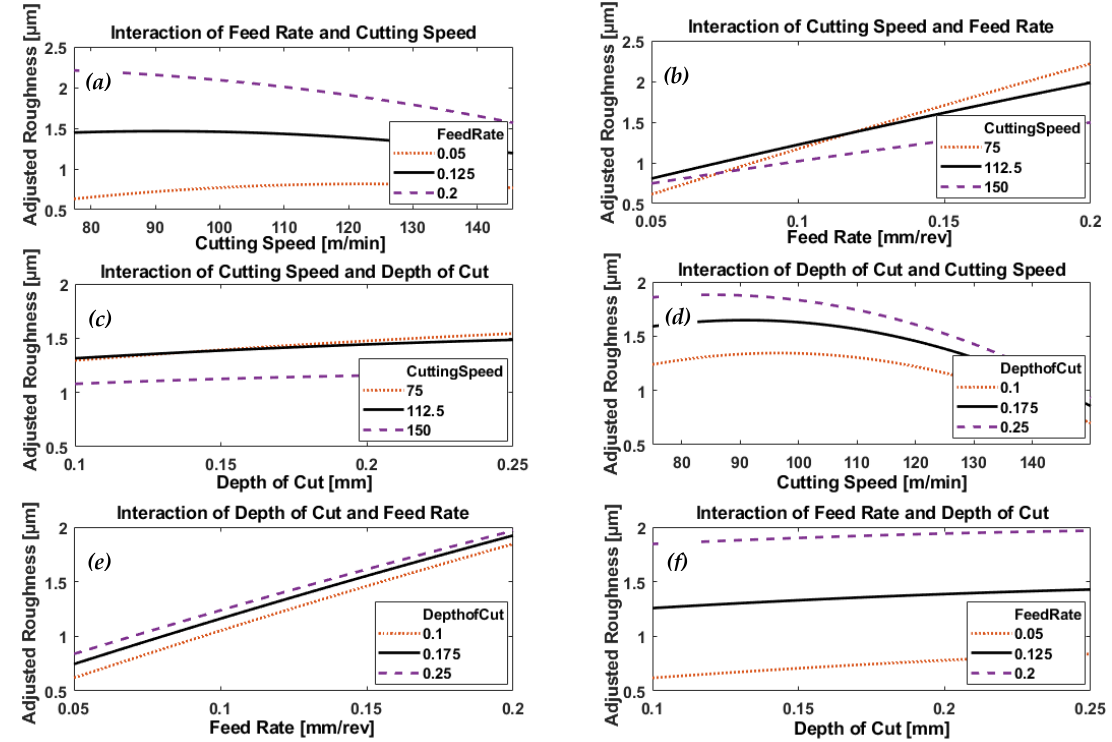
Figure 10. Plots depicting the interactive effects of feed rate, cutting speed, and depth of cut on generated surface roughness of AISI 4340 specimens machined by conventional inserts; ( a ) the effect of cutting speed at different levels of feed rates, ( b ) the effect of feed rate under different levels of cutting speeds, ( c ) the effect of depth of cut at different levels of cutting speeds, ( d ) the effect of cutting speed under different levels of depth of cuts, ( e ) the effect of feed arte at different levels of depth of cuts and ( f ) the effect of depth of cut under different feed rates.